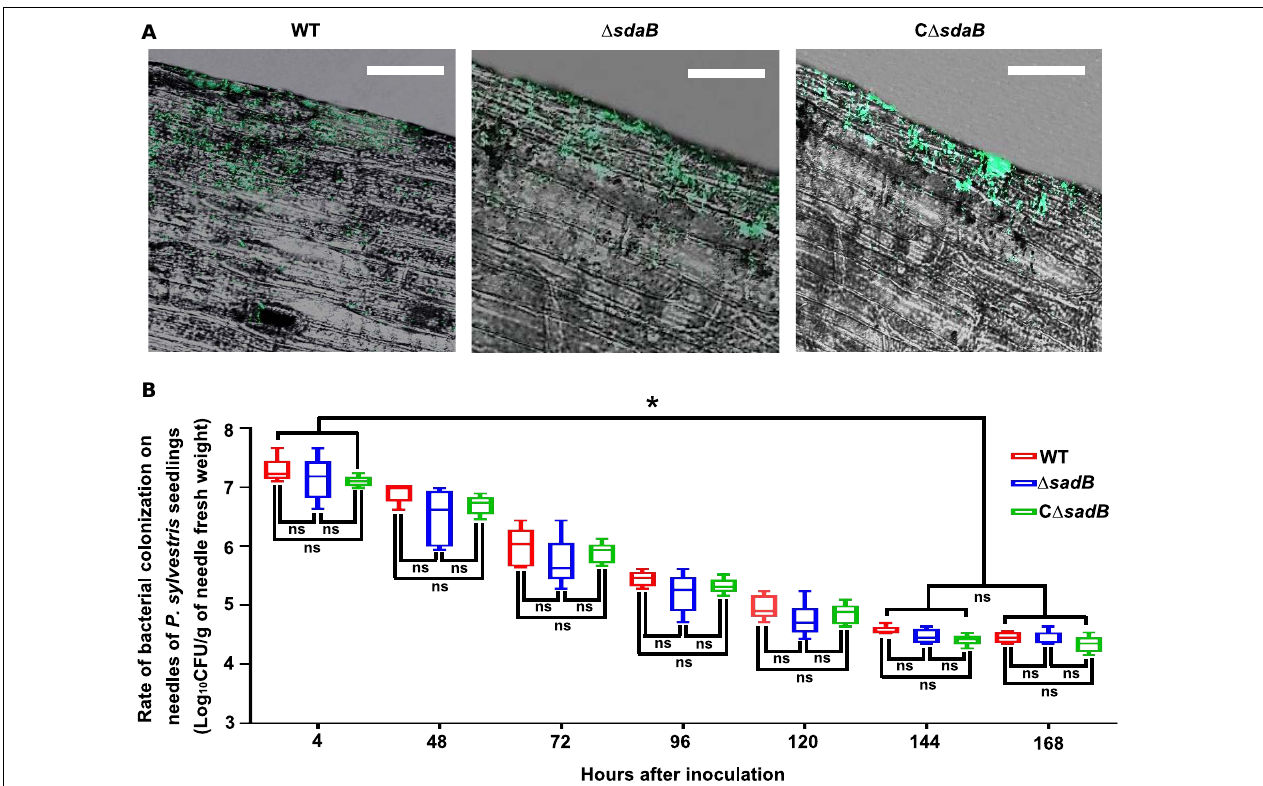
FIGURE 7 | Colonization of E. ludwigii AA4 on needles of P. sylvestris seedlings. (A) Image analysis of needle colonization of green fluorescent protein (GFP)-labeled wild-type AA4, AA4 sdaB gene knock-out mutant, and AA4 (cid:49) sdaB complemented with a wild-type sdaB gene. These images were taken using a confocal laser scanning microscope at 48 h post inoculation (Scale bars: 20 µ m). (B) The abundance of wild-type AA4, AA4 sdaB gene knock-out mutant, and AA4 (cid:49) sdaB complemented with a wild-type sdaB gene colonizing on the needles of P. sylvestris seedlings. WT, AA4 wild-type strain; (cid:49) sdaB , AA4 sdaB gene knock-out mutant; C (cid:49) sdaB , AA4 (cid:49) sdaB complemented with a wild-type sdaB gene. The asterisks indicate that differences among the means represented by the columns are statistically significant (* p ≤ 0.0041). Two-tailed t -test (GrapPad Prism 8) was used for the